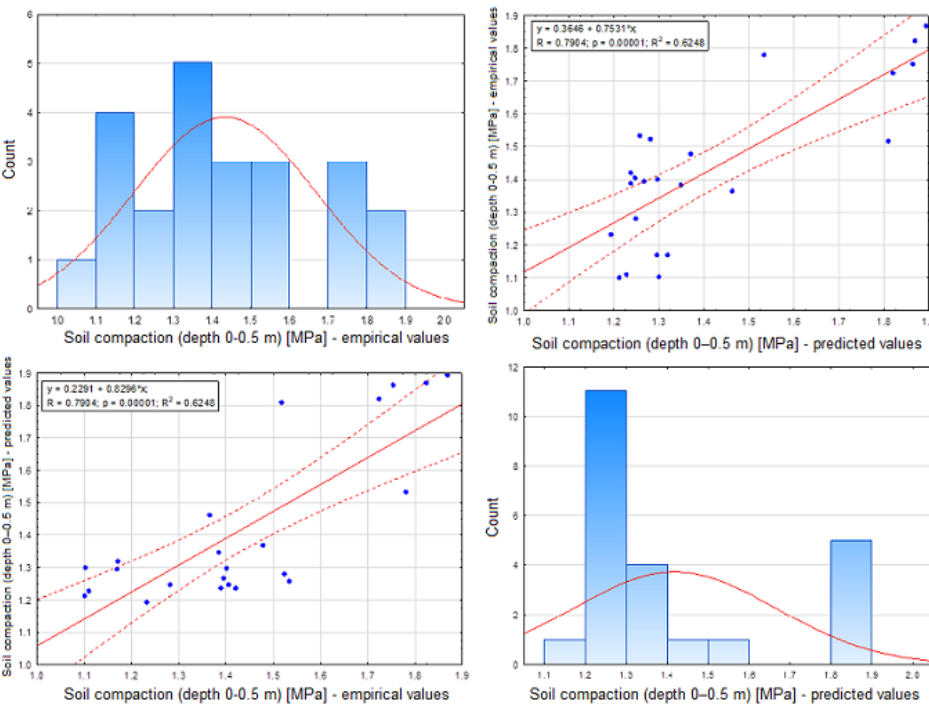
Figure 3. The scatter matrix graph for the validation dataset (MLPSC_0_0.5 model).